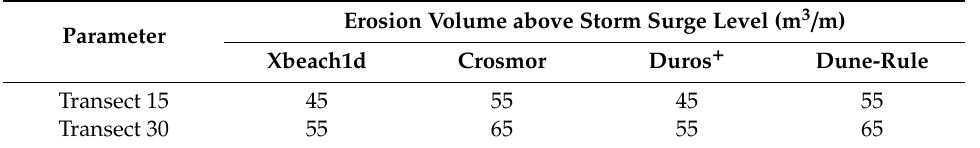
Table 4. Comparison of dune erosion volumes above storm level for transects 15, 30; d 50 = 0.25 mm.